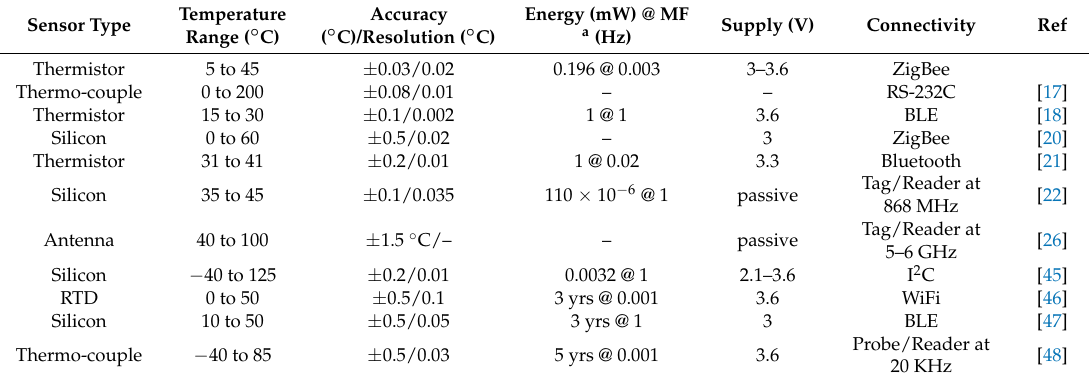
Table 9. Comparison of different temperature measurement sensors (the first entry refers to our